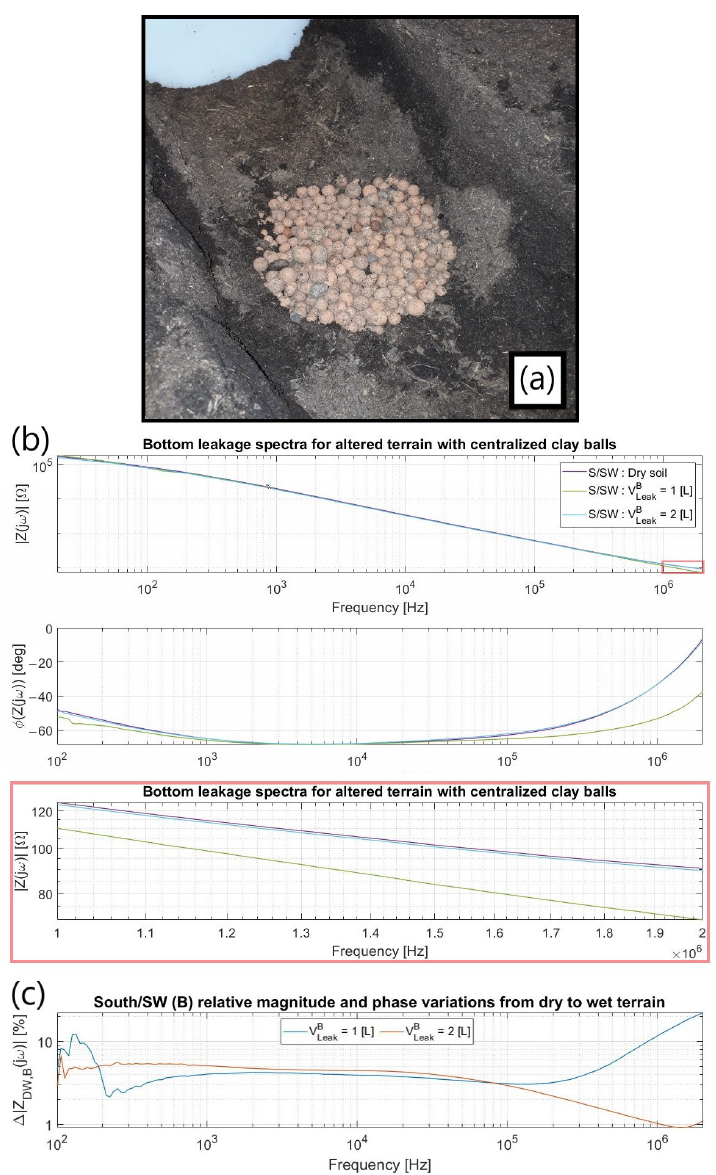
Figure 16. ( a ) Setup after bottom leakage (V BLeak ) ceased; ( b ) Attained spectra, S/SW being the electrode “triplet” used (concept explained in Section 3.4). The zoom in red highlights the impedance variation at the zone where R Soil starts to take over; ( c ) Idem, but normalized by a dry soil baseline.